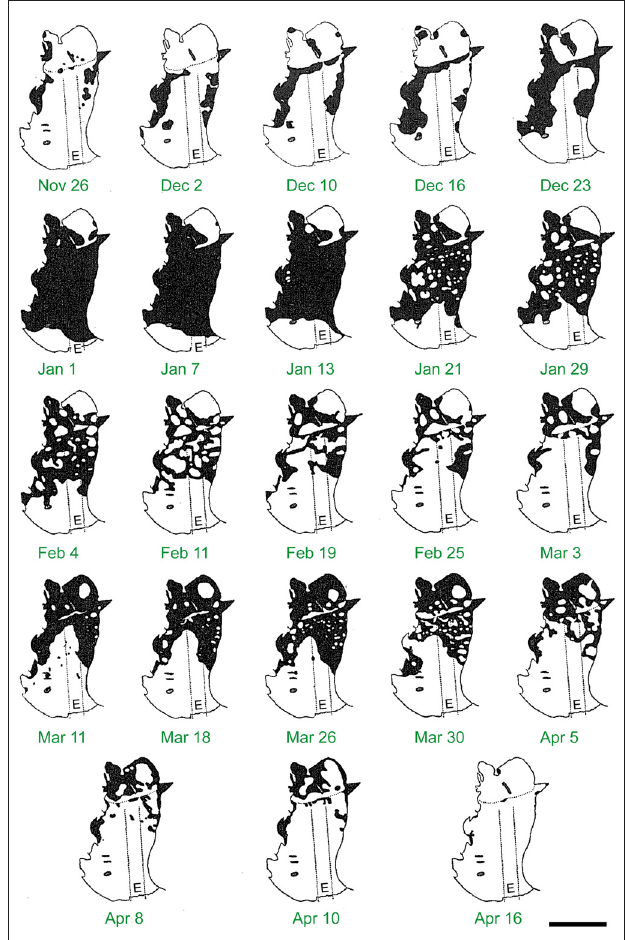
FIGURE 8 | The build up and decline of Bogong moth numbers on the roof of Ian Common’s observation cave on Mt Gingera over the summer of 1952–1953. Each panel shows the area of the cave roof monitored and the black areas are the areas covered by Bogong moths. Numbers became maximal at New Year and then slowly declined until the beginning of March, with moths gradually disappearing first from the more exposed parts of the cave near its entrance (E) . Note the upswing in moth numbers from mid to late March—moths migrating from further south were apparently using this cave as a temporary shelter during their northward journey. Dotted lines show the width and length of the trench Common dug to assist entry to the cave. Scale bar = 2 m. Reproduced from Common (1954), with permission from CSIRO